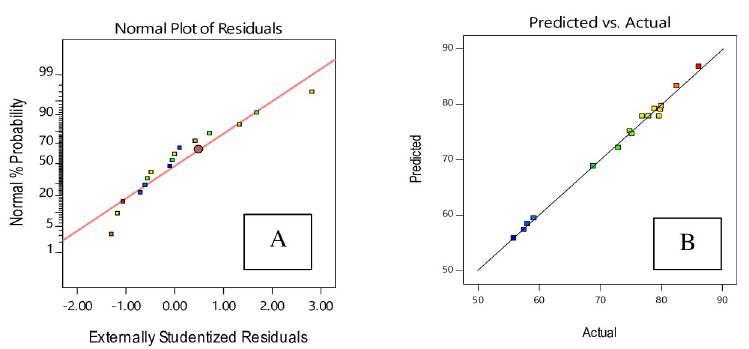
Fig 10. The residual plots for degree of crystallinity of HAp nano powder using hydrothermal method, based on CCD. A: normal probability; B: residuals versus predicted.